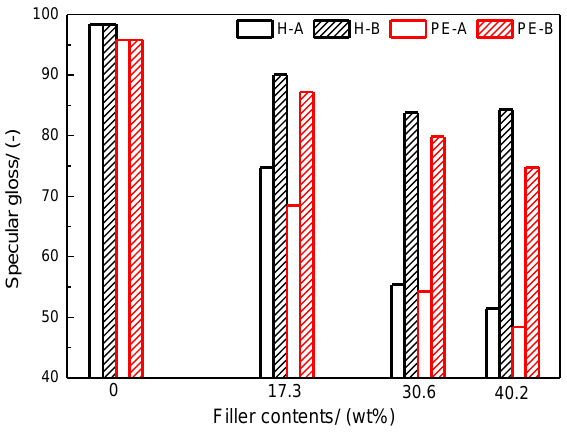
Figure 11. Specular gloss of samples with different fillers and filler contents at 60°.